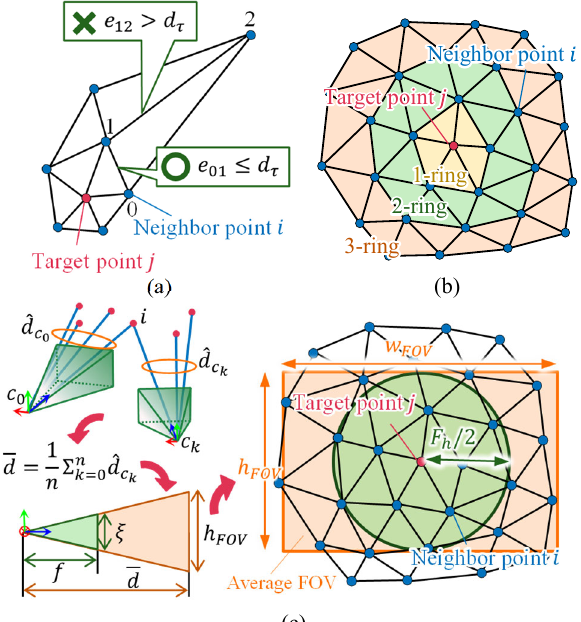
Figure 4. Selection conditions of the neighbor point 𝑖 ; (a) the edge length (condition 1), (b) selection using the 𝑘 -ring region of 𝑖 (condition 2a), and (c) selection using the FOV height of an existing camera (condition